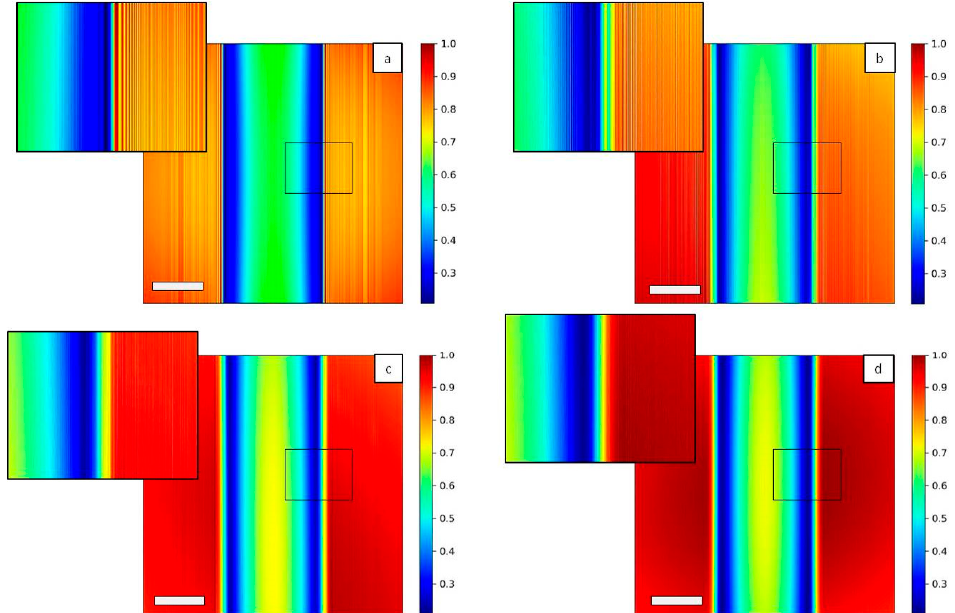
Figure 4. 2D intensity map of a Polymethylmethacrylate (PMMA) cylinder normalized to the incident beam for di ff erent values of N : ( a ) N = 1, ( b ) N = 10, ( c ) N = 100 and ( d ) N = 1000. Di ff raction lines can be seen in the case of full coherence ( a ). For higher N , the oscillations attenuate ( b , c ), while the image is smoothed for incoherent illumination ( d ). Scale bars are 25 µ m.